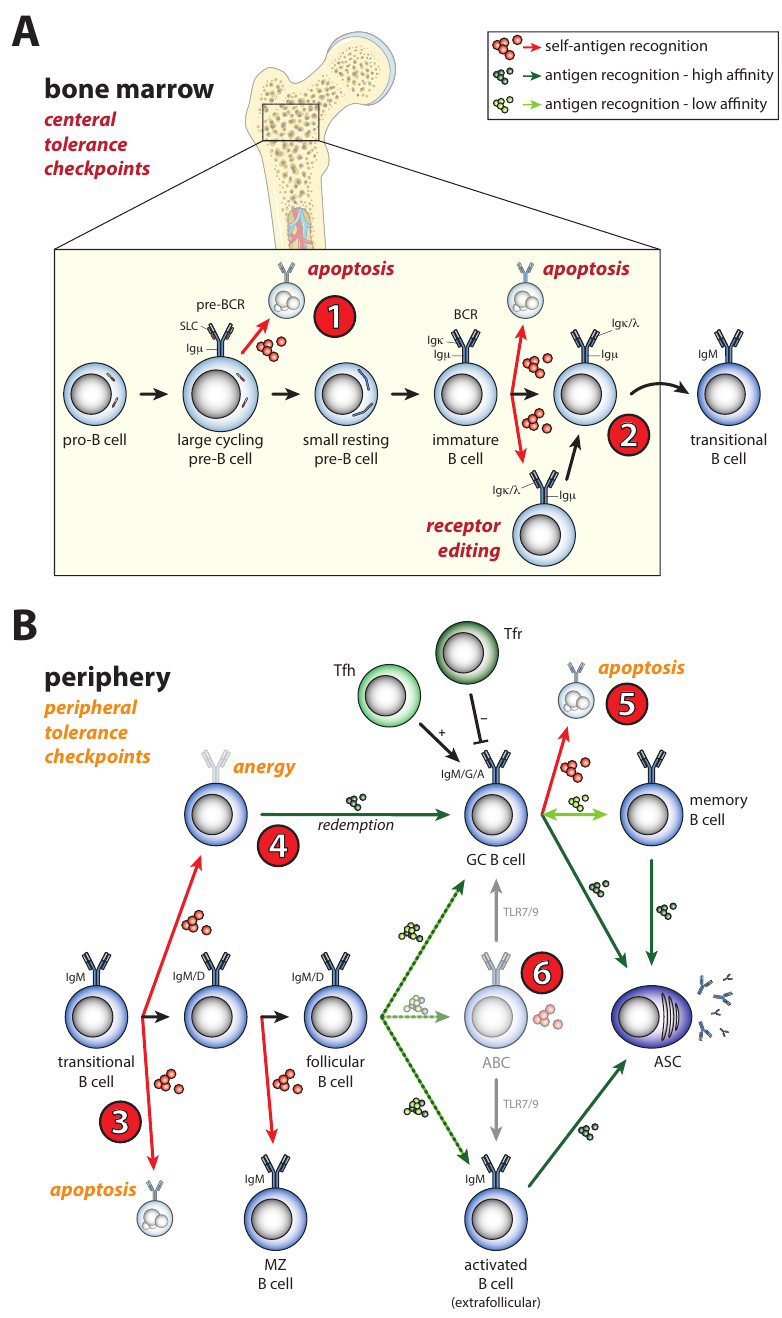
Figure 1. B cell selection is controlled by B cell receptor signals at several points during B cell development and activation. At several checkpoints during B cell development in the bone marrow (central tolerance) and B cell maturation and activation in the periphery (peripheral tolerance), autoreactive B cells can escape negative selection that is dependent on B cell receptor (BCR)